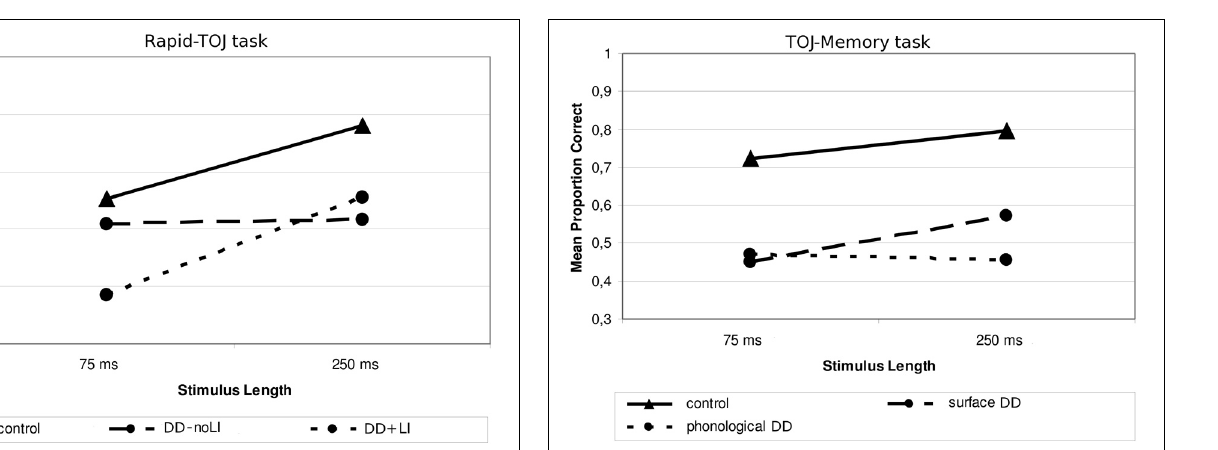
FIGURE 6 | Mean proportion of correct answers in the TOJ—Memory task for the subgroups divided according to Type of Dyslexia.